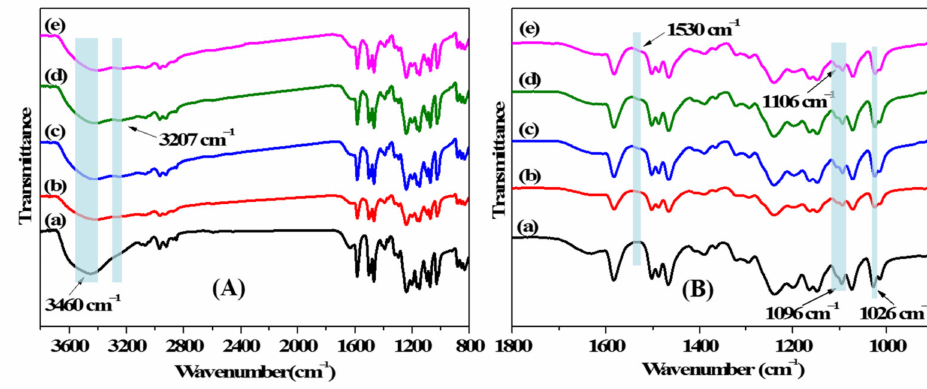
Figure 4. FT-IR spectra of membranes (a) M-0, (b) M-12C4-0.75, (c) M-PEI, (d) M-12C4-0.75-PEI, and